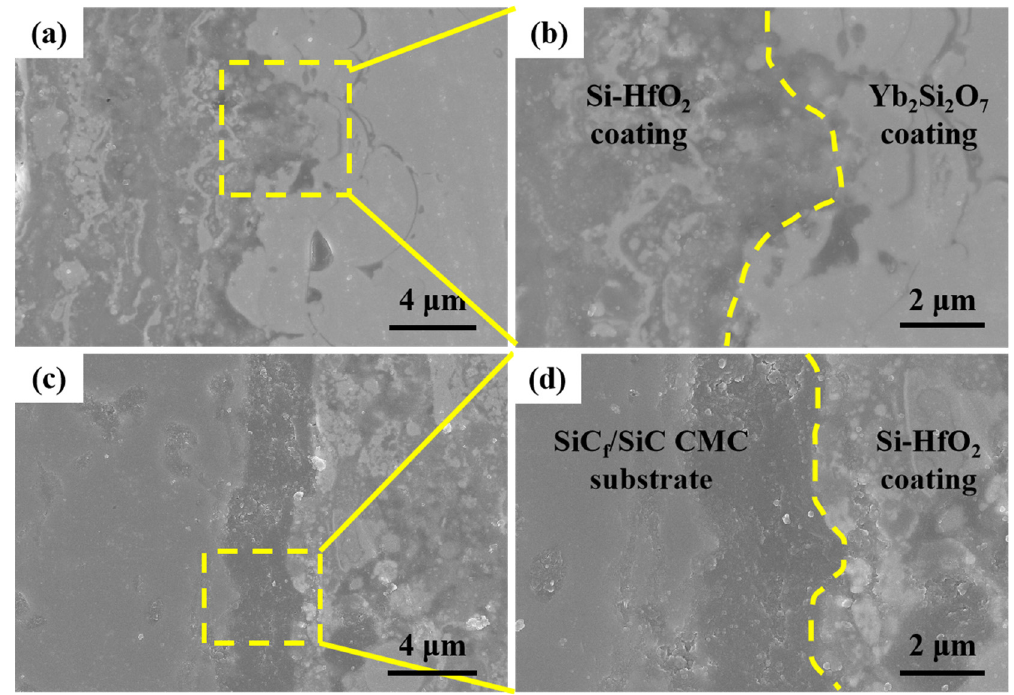
Figure 9. Cross-section micromorphology: ( a ) Si–HfO 2 /Yb 2 SiO 7 interface; ( b ) enlargement of ( a ); ( c ) SiC/C/Si–HfO 2 interface; ( d ) enlargement of ( c ).